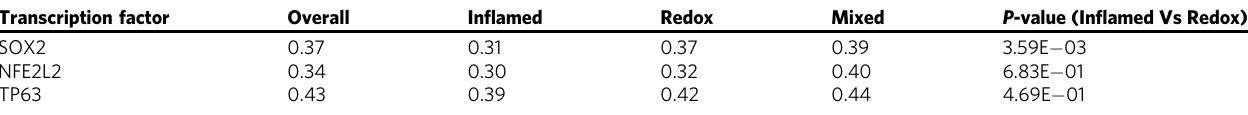
Table 3 Average transcript-protein correlations of transcription factor targets Transcription